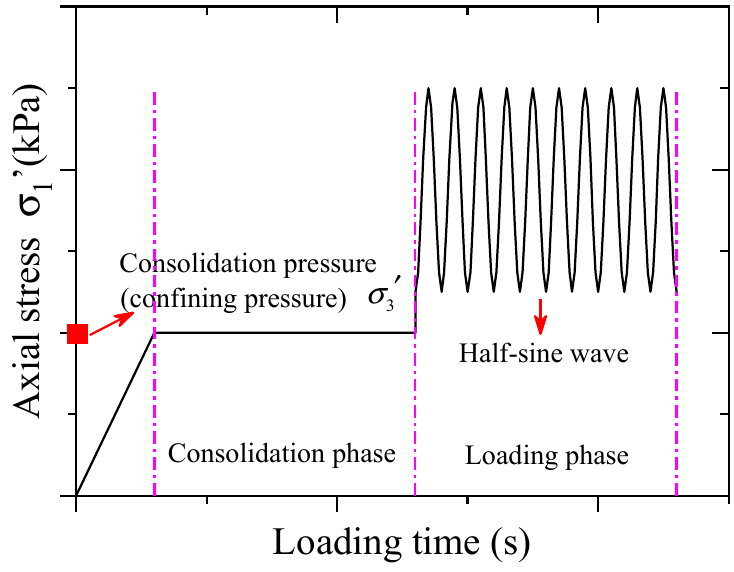
Figure 6. Loading process under cyclic loading.